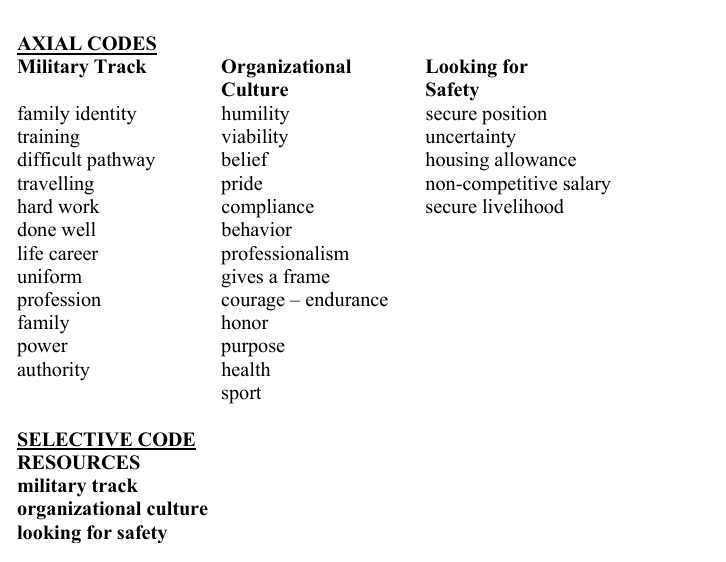
Figure 2. An example of the analytic process—basic codes (first step) to axial codes (second step) to selective code (third step).